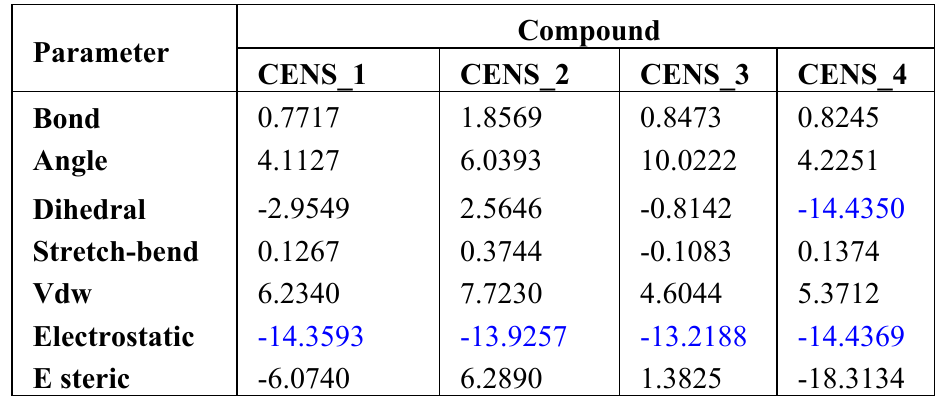
Table 1: The detailed energies of the most favored conformations of the four